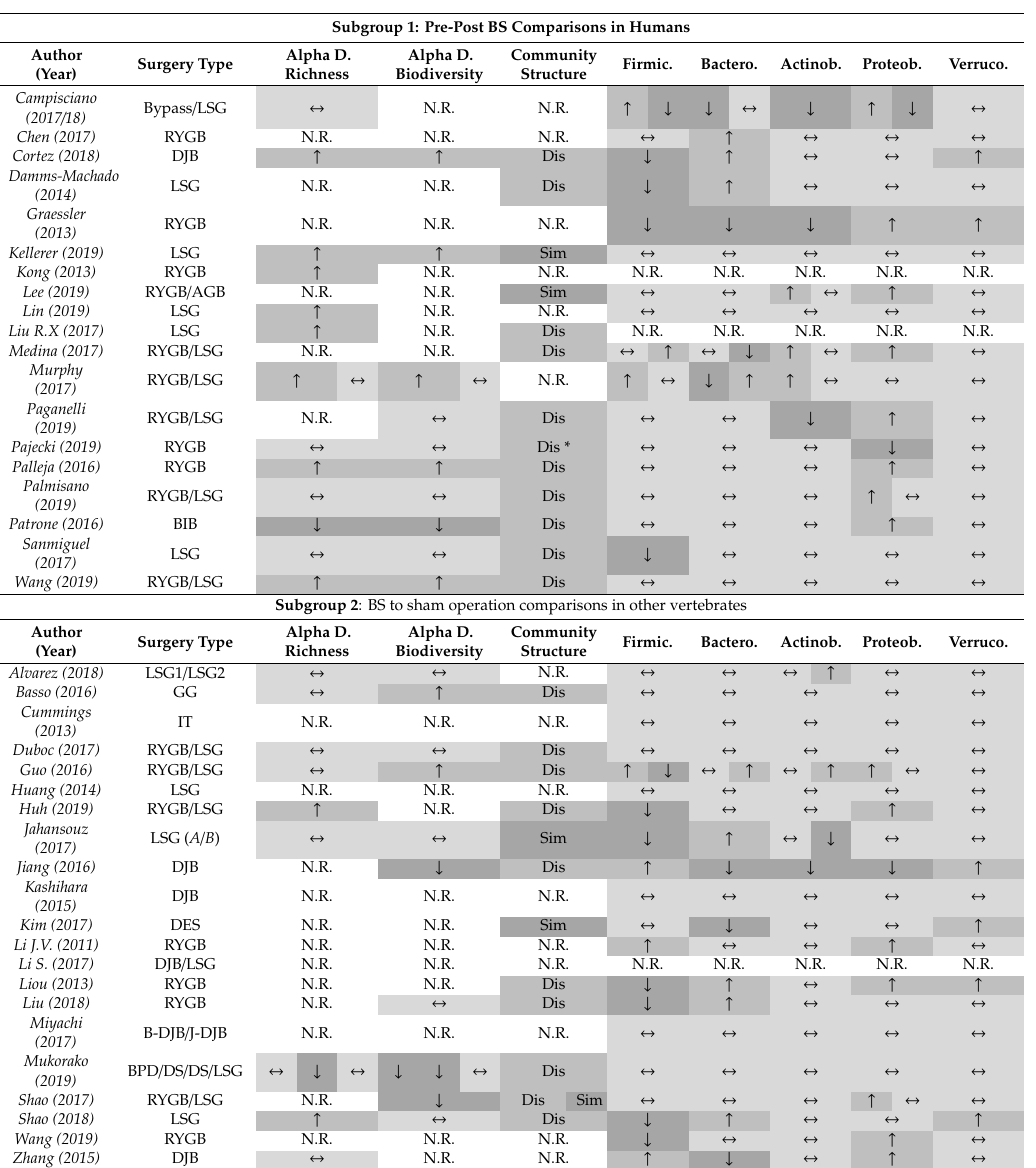
Table 3. Subgroup analysis outcomes for alpha diversity, community structure, and taxonomy changes at the phylum